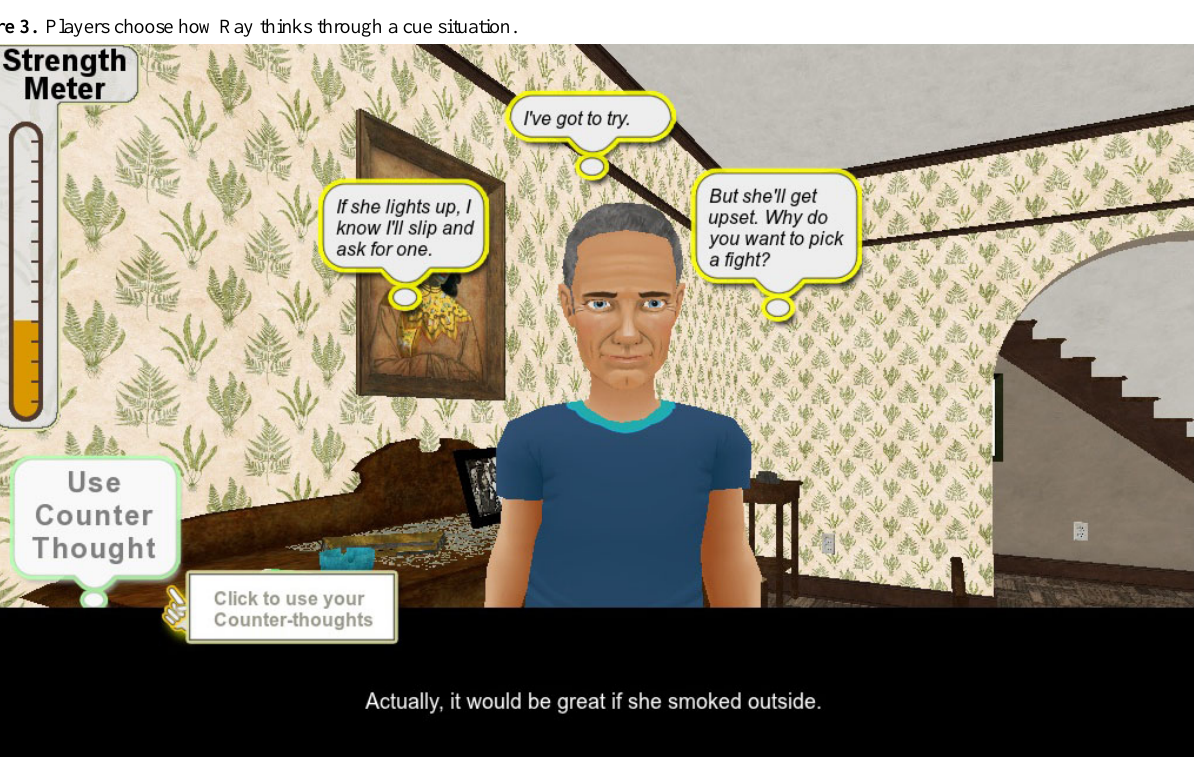
Figure 3. Players choose how Ray thinks through a cue